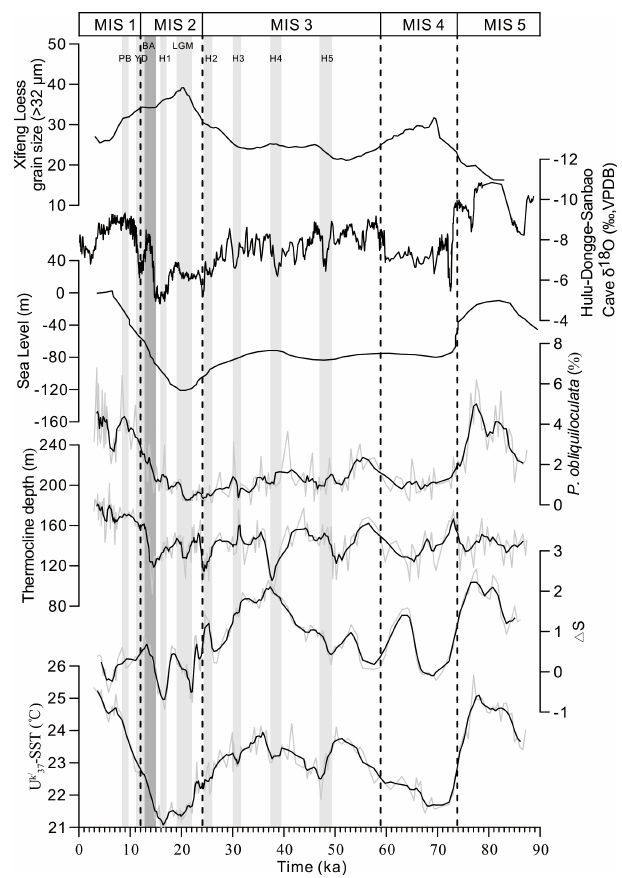
Figure 9. Time series plots of temperature, salinity, depth of the thermocline and the contents of P. obliquiloculata , compared to sea level (Cutler et al., 2003); δ 18 O curve of cave stalagmite from East China (Wang et al., 2001, 2008; Yuan et al., 2004); grain size of Xifeng loess (Guo et al., 2009). Gray bars are the same as those in Fig.